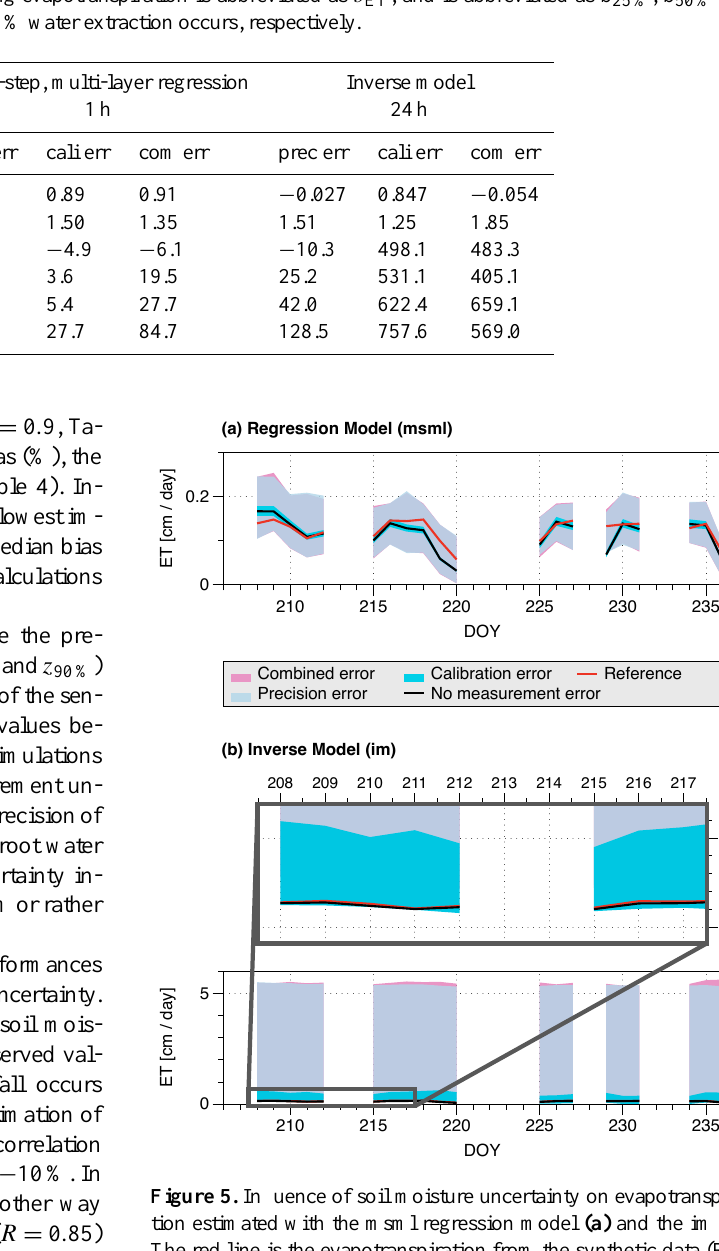
depths, whereas uncalibrated sensors lead to considerable in- creases in relative bias. Overall, the simpler msml regression method shows a higher robustness against measurement un- certainties than the more complex